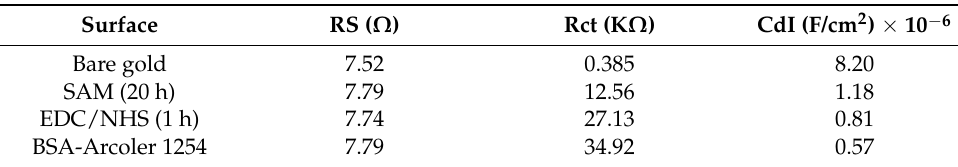
Table 3. Parameter evaluation for the Randle’s model on a gold